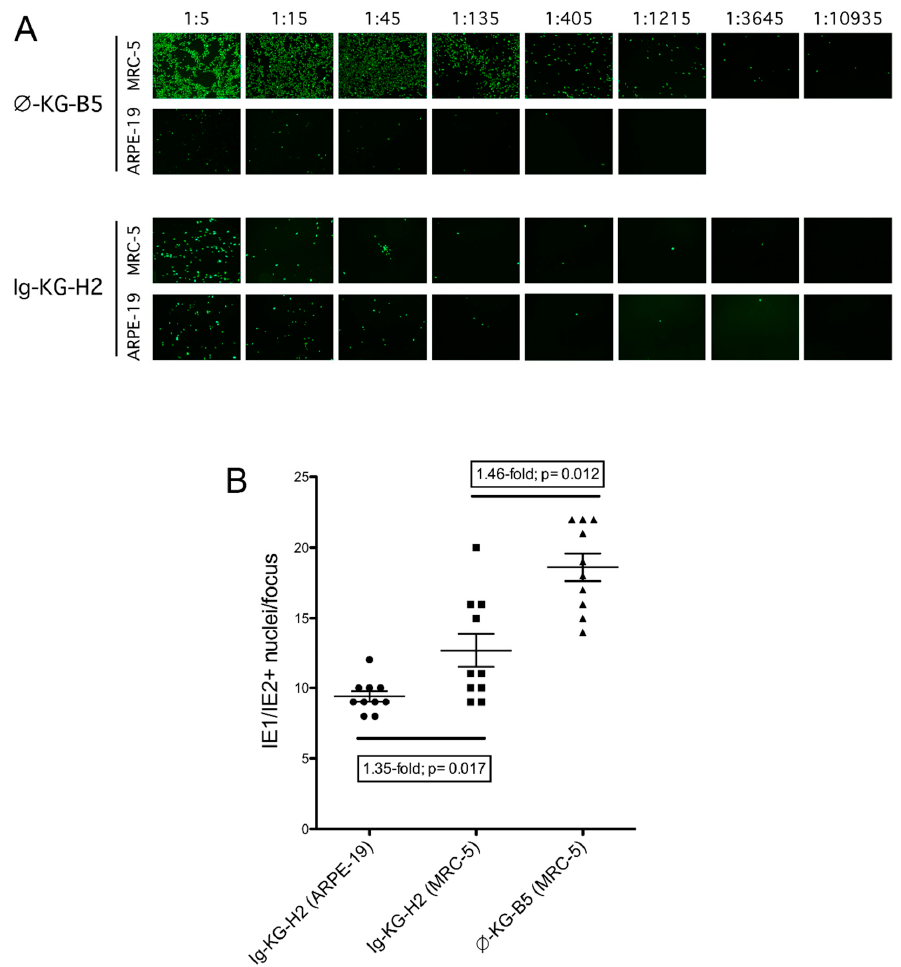
Figure 3. Subcloned viruses retain the tropisms of their parental stocks. ( A ) Viruses φ -KG-B5 and Ig-KG-H2 were isolated from φ -KG passage 13 or Ig-KG passage 22 stocks, respectively, and then evaluated for infection of MRC-5 or ARPE-19 cells as described in the legend for Figure 1B. Images were taken using a 10 × objective. ( B ) The numbers of IE1/IE2-positive nuclei in ten foci from MRC-5 or ARPE-19 cultures infected with φ -KG-B5 or Ig-KG-H2 were manually counted. Fold differences in the means and p -values (two-tailed t -test) are indicated. Stocks B5 and H2a were used in both experiments.